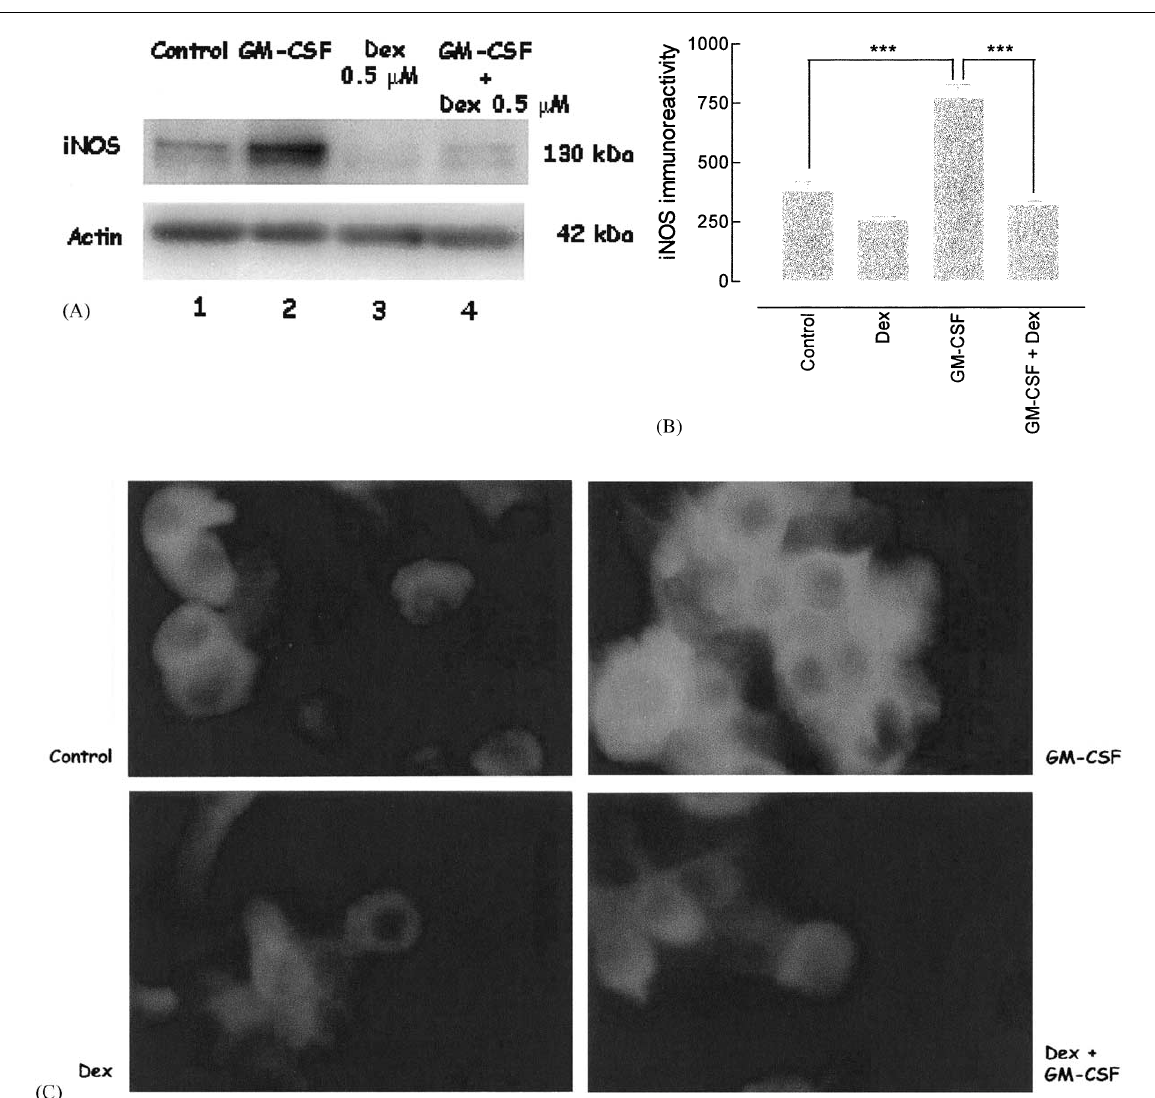
FIG. 2. Effect of dexamethasone (Dex) on GM-CSF-induced iNOS protein expression in FSDC. (A) Western blot analysis of iNOS and actin protein levels. FSDC cells (2 (cid:3) / 10 6 cells) were incubated for 24 h with culture medium alone (control, lane 1), with 100 ng/ml of GM-CSF (lane 2), with 100 ng/ml of GM-CSF in the presence of 0.5 m M dexamethasone (lane 4), or with 0.5 m M dexamethasone alone (lane 3). When the effects of dexamethasone on the response to GM-CSF was investigated, the cells were pre-incubated with the corticosteroid for 30 min. Total cell extracts were electrophoresed through sodium dodecyl sulfate-polyacrylamide gel electrophoresis, transferred to polyvinyl difluoride membranes and subjected to western blot analysis using an anti-iNOS antibody as described in Materials and methods. The membrane was stripped and reprobed with anti-actin antibody to confirm equal protein loading. The blot shown is representative of three blots yielding similar results. (B) The results obtained in three independent experiments were quantified with an image analyzer and the results are presented as means 9 / standard error of the mean. ***p B / 0.001, as determined by one-way analysis of variance with Bonferroni’s multiple comparison test. (C) Immunofluorescence analysis of iNOS protein. FSDC cells (0.2 (cid:3) / 10 6 ) were incubated under the same conditions as performed for western blot